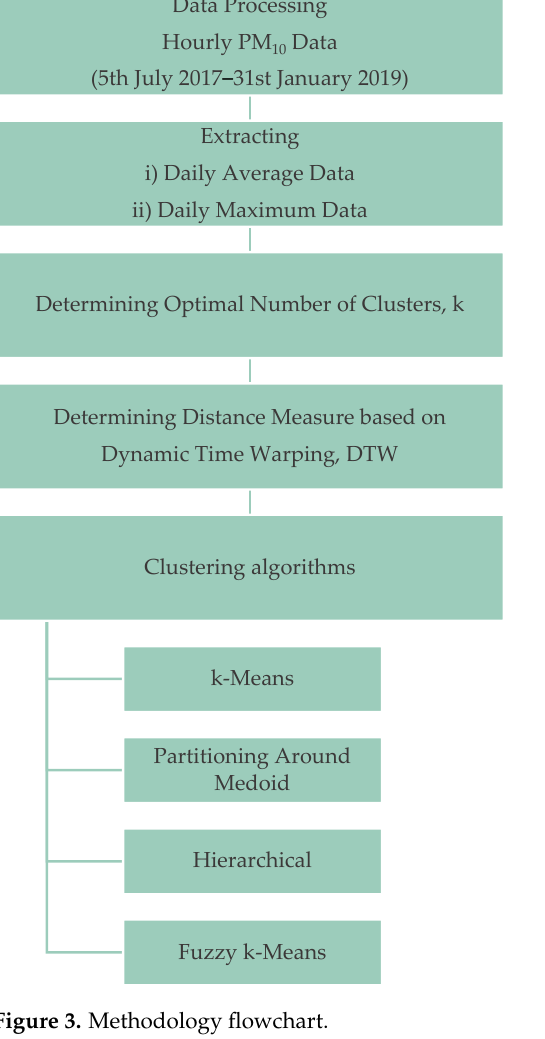
Figure 3. Methodology flowchart.